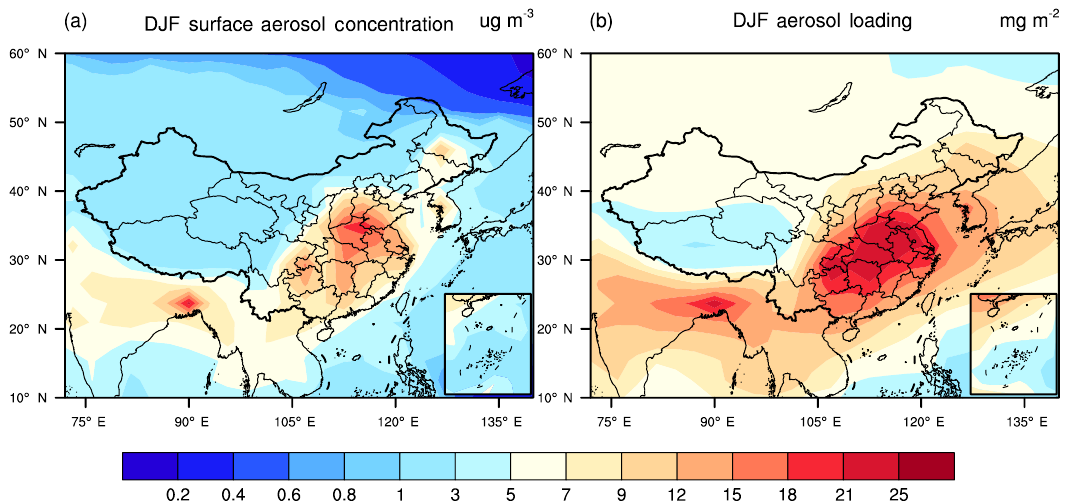
Figure 6. The simulated winter-average (a) surface aerosol concentrations (units: µgm − 3 ) and (b) aerosol loadings (units: mgm − 2 ) in the group of